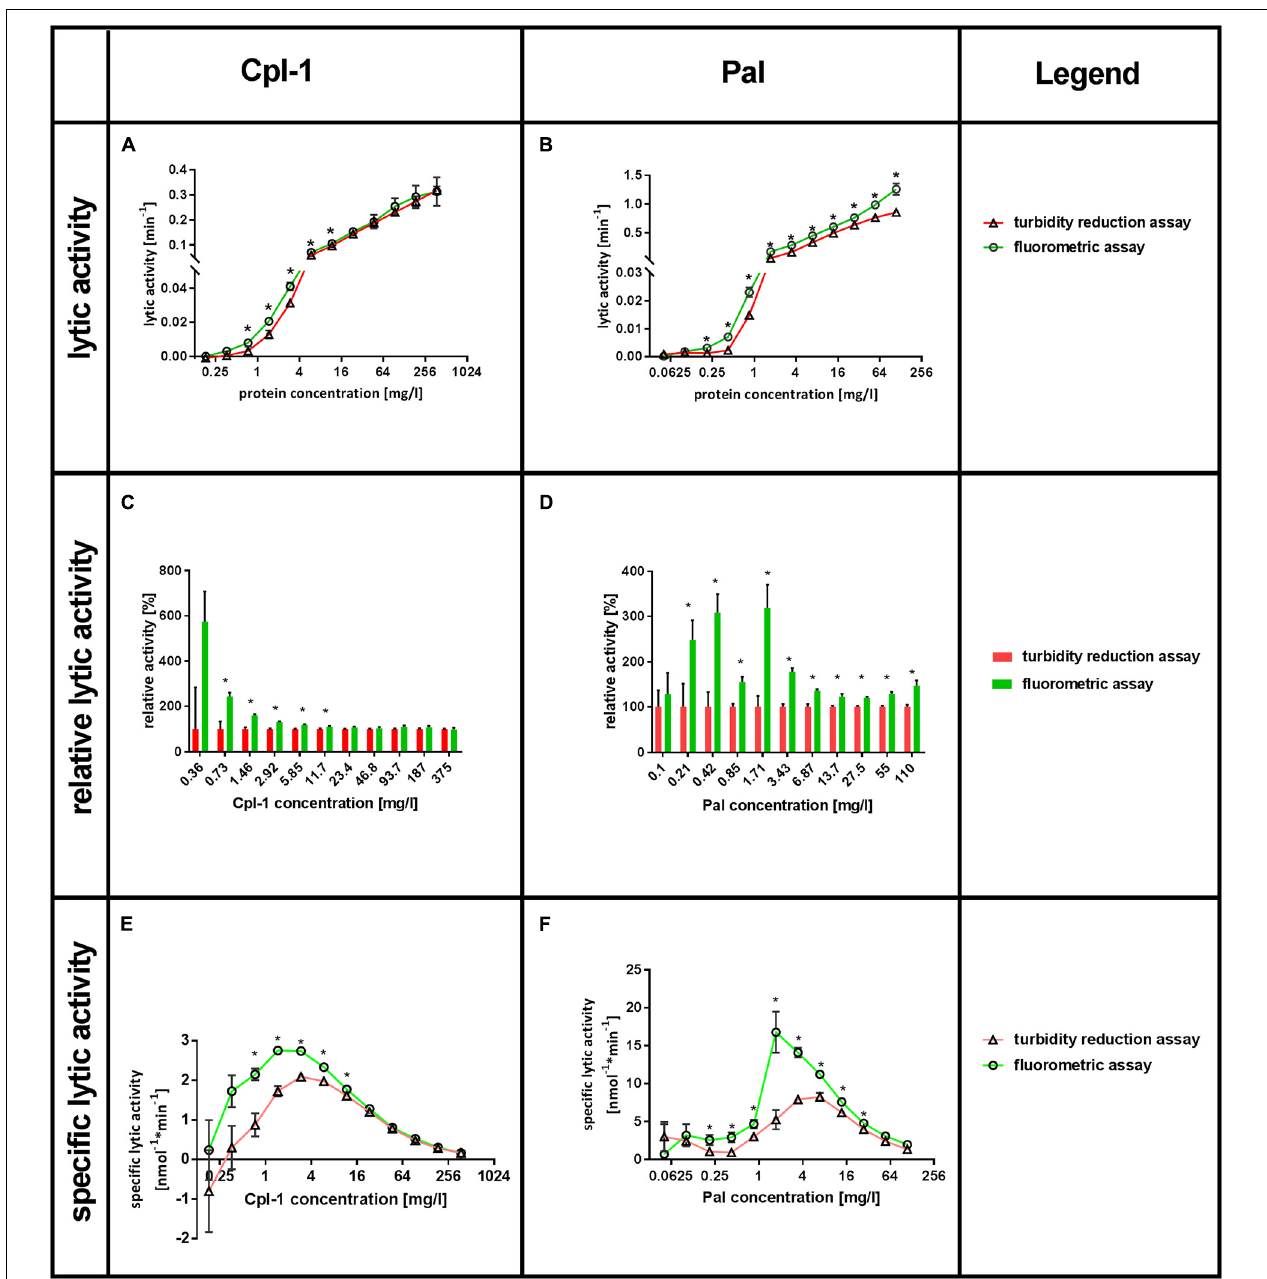
FIGURE 3 | Comparison of SytoxTM Green fluorometric assay and turbidity reduction assay in characterisation of Cpl-1 and Pal. Bacterial lysis was detected in PBS (200 µ L) with 1.6 × 10 7 CFU, Cpl-1 or Pal at indicated concentrations and 0.25% DMSO or Sytox Green solution (turbidity reduction or fluorometric assay, respectively, see Materials and Methods for details). Lytic activity of Cpl-1 (A) and Pal (B) is measured by both methods in concentrations ranging from 0.05 to 110 mg/L for Pal and from 0.18 to 375 mg/L for Cpl-1. Comparison of relative lytic activities for Cpl-1 (C) and Pal (D) . Specific lytic activity of Cpl-1 (E) and Pal (F) measured by both methods. (*) Stars show statistically significant difference in activity as detected by the two methods (adj. p < 0.05). Points represent results of two identical experiments. Bars represent the standard